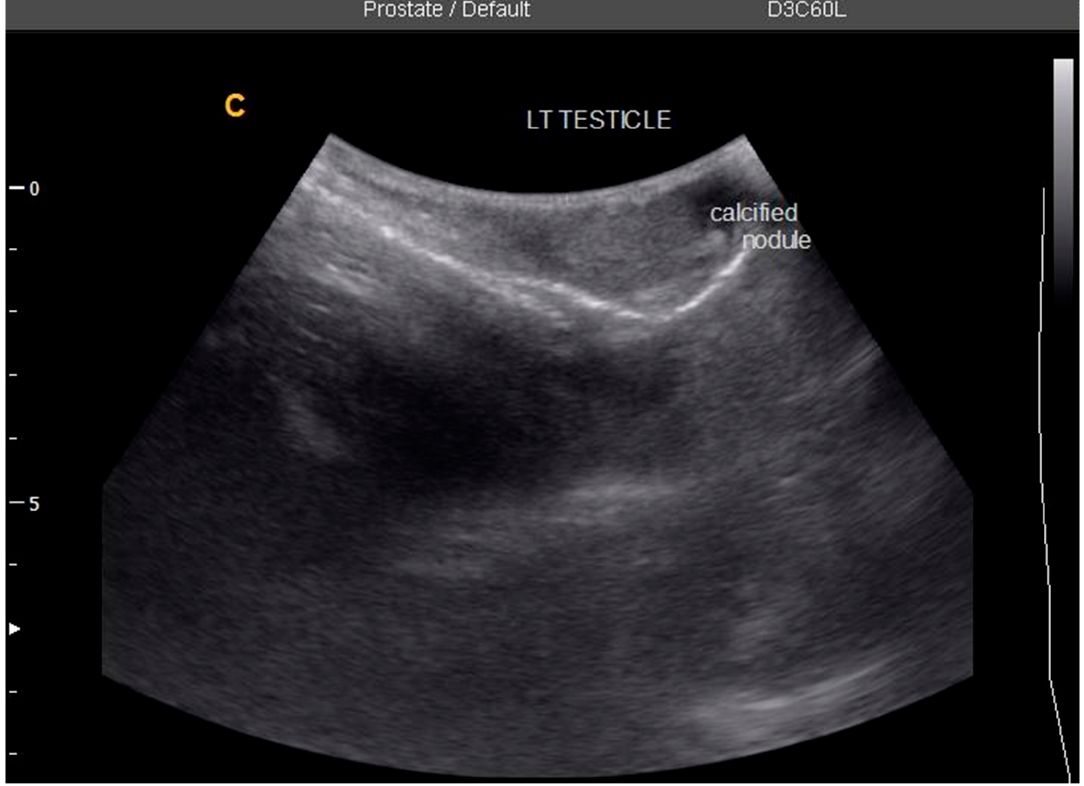
Figure 5. Ultrasonographic image of study participant with left testicular nodule at baseline.